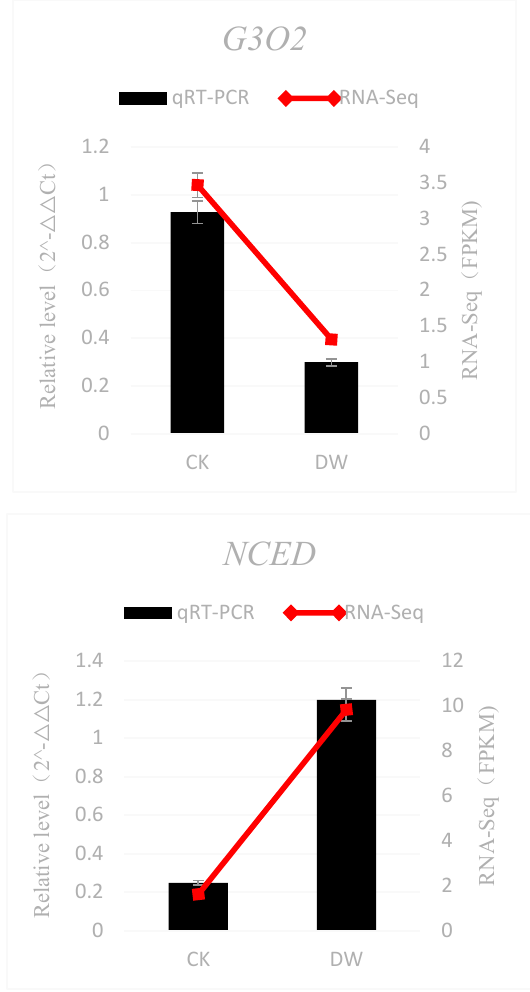
Figure 13. Validation of RNA-Seq results using qRT-PCR. CK is the control group and DW is the cold-treated group: (CK: 25 °C; DW: 1 °C).